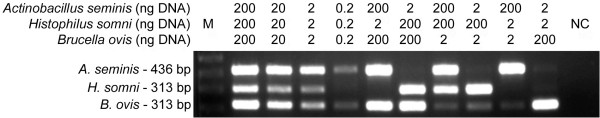
Representative agarose gel electrophoresis resolving products from a multiplex PCR assay for detection of Brucella ovis, Actinobacillus seminis,
 and Histophilus somni with genomic DNA extracted from pure cultures. M: molecular weight marker; NC: negative control without genomic DNA.